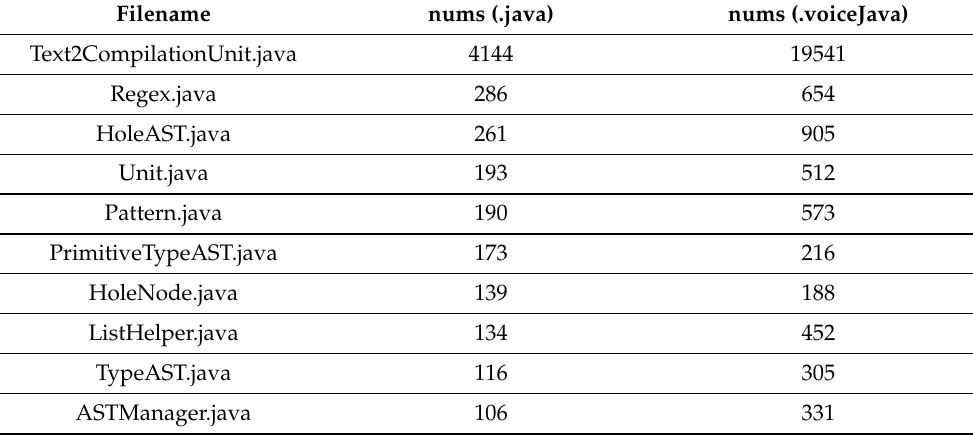
Table 3. A comparison between Java and